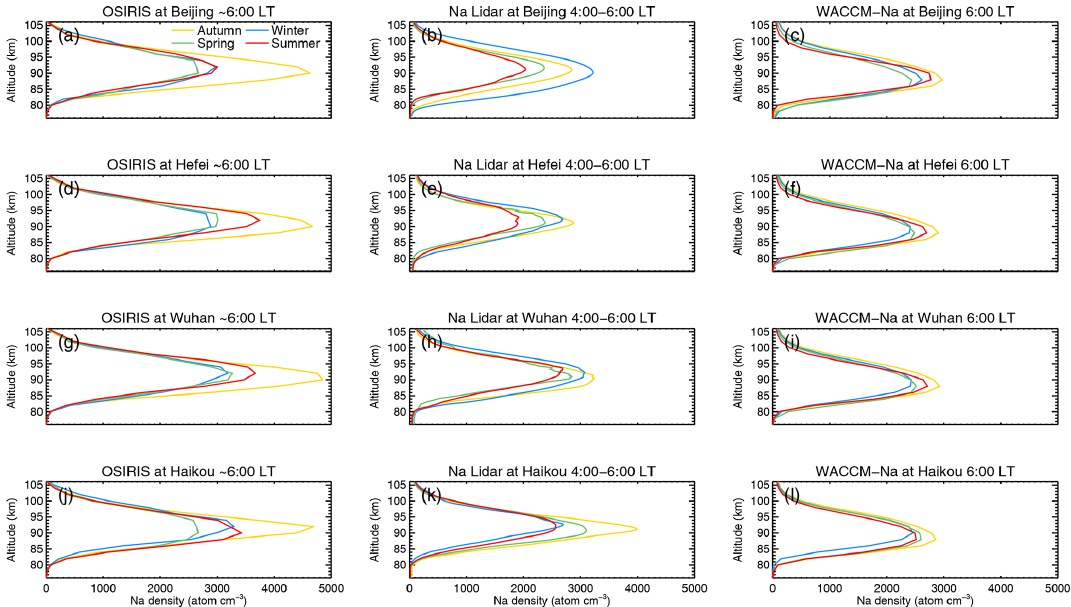
Figure 13. Comparisons of seasonal Na number density profiles in the morning from OSIRIS at 06:00LT, Na lidars at 04:00–06:00LT, and WACCM–Na at 06:00LT (a–c) at Beijing, (d–f) Hefei, (g–i) Wuhan, and (j–l) Haikou.